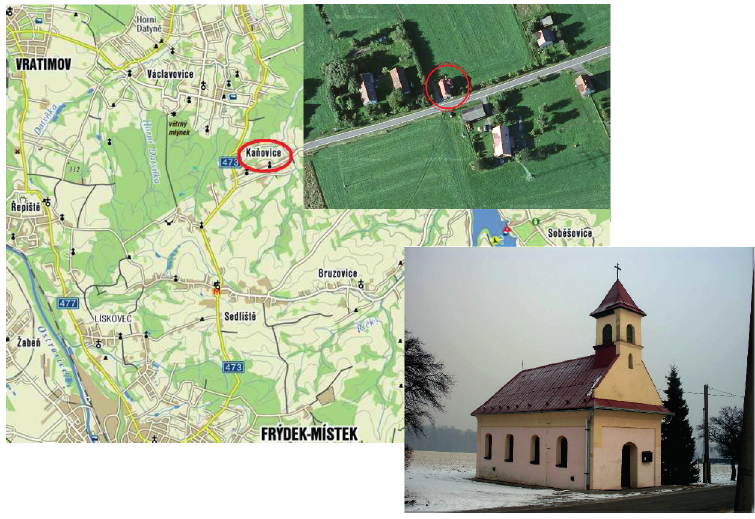
Fig. 4. Structure localization (GPS 49°44´31´´ N, 18°23´20´´ E)